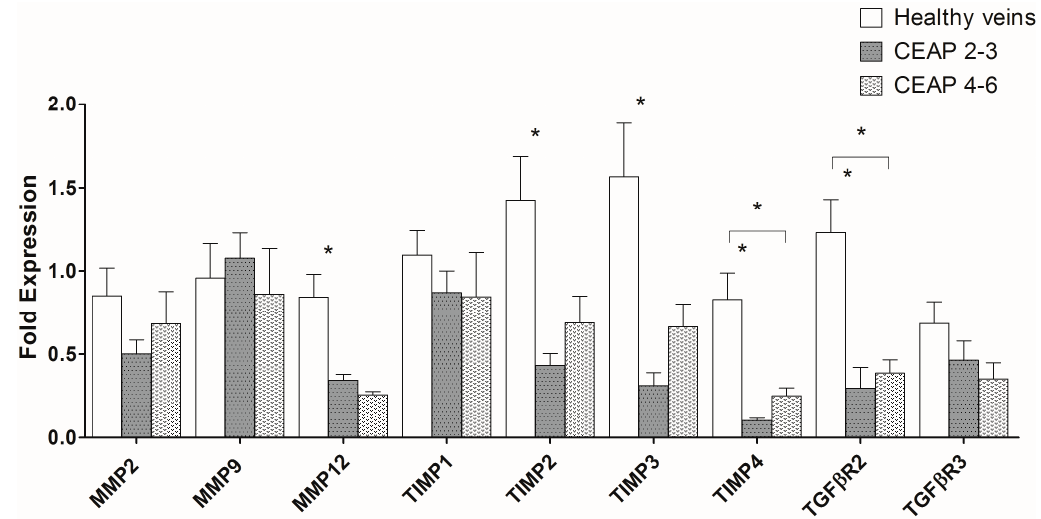
Figure 2. MMP, TIMP, and TGF β R gene expression in healthy, CEAP2–3, and CEAP4–6 veins (from the tibiotarsal junction). Their gene expression was determined by qPCR and after normalization with β -actin housekeeping gene. All results are expressed as fold expression. Error bars indicate mean ± standard error of the mean (SEM), n (healthy) = 13, n (CEAP2-3) = 10, and n (CEAP4-6) = 6. * p ≤ 0.05. Comparisons between the CEAP2–3 and CEAP4–6 vein groups (Figure 3) from different anatomic harvest sites (tibiotarsal, saphenofemoral, and tributaries) were also performed. No significant differences in MMP, TIMP, and TGF β R gene expression were found between the two CVeD groups from the tibiotarsal junction. From the saphenofemoral junction, only MMP9 gene expression was significantly lower in the CEAP4–6 veins ( p = 0.027). Finally, in varicose tributary veins, MMP2 ( p = 0.002) and TIMP3 ( p = 0.050) gene expressions were significantly increased, while TGF β R3 gene expression ( p = 0.002) was significantly decreased in the CEAP4–6 group.